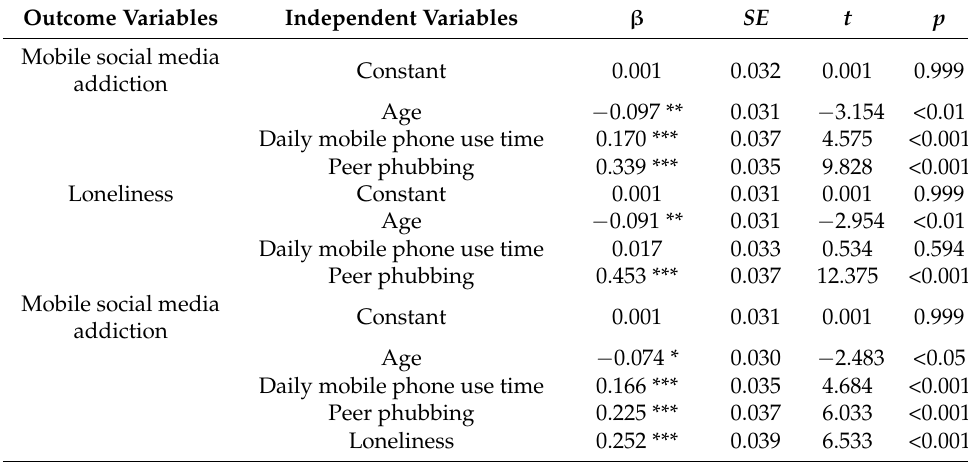
Table 3. Mediation analysis of the role of loneliness. Outcome Variables